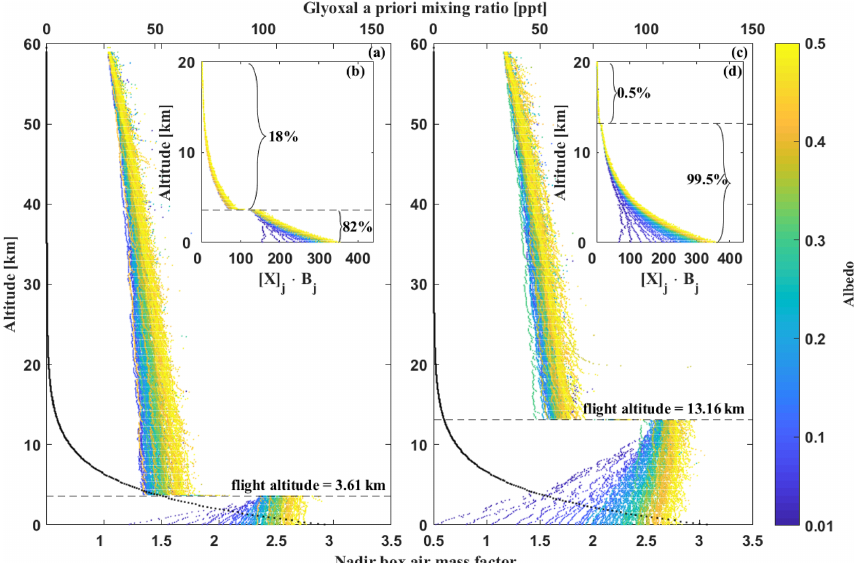
Figure 2. Box air mass factors ( B j ; lower x axis of panels a and c ) of two mini-DOAS nadir measurements in the lower (a, b) and upper (c, d) troposphere for changing surface albedos between 0.1 and 0.5 (colour code). Both simulations were performed for the research flight from Oberpfaffenhofen (Germany) to Sal (Cabo Verde) on 7 August 2018. For the radiative transfer simulations, no clouds but rater aerosol profiles, as described in the text, are assumed (see Sect. 2.1.4). The product of B j and the assumed a priori glyoxal concentration [ X ] j (upper x axis of panels a and c ; black circles) yields the relative contribution of each altitude layer j (b, d) . Evidently, even airborne nadir measurements at lower altitudes predominantly, but not exclusively, probe the atmosphere below the flight altitude. This causes the necessary restriction to upper tropospheric flight altitudes for the intercomparison of air- and spaceborne measurements, as discussed in Sect.